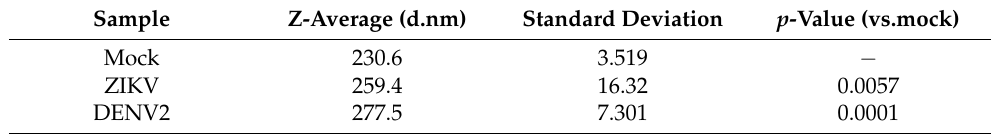
Table 1. Increased size of exosome during both ZIKV and DENV2